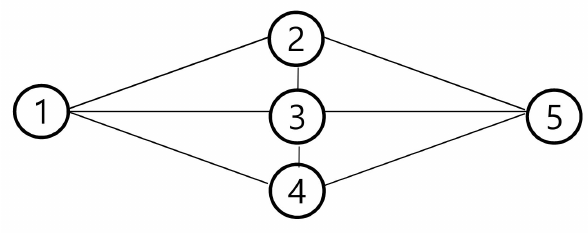
Figure 4. A network consisting of 5 nodes and 8 edges.